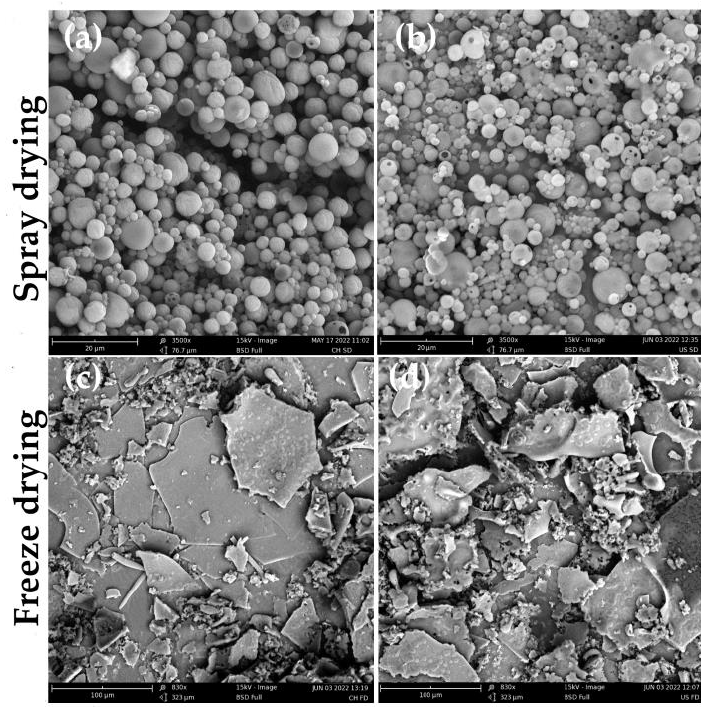
Figure 3. Scanning electron microscopy images. ( a ) Conventional homogenization spray-drying, ( b ) Ultrasound probe homogenization spray-drying, ( c ) Conventional homogenization freeze-drying, ( d ) Ultrasound probe homogenization freeze-drying.